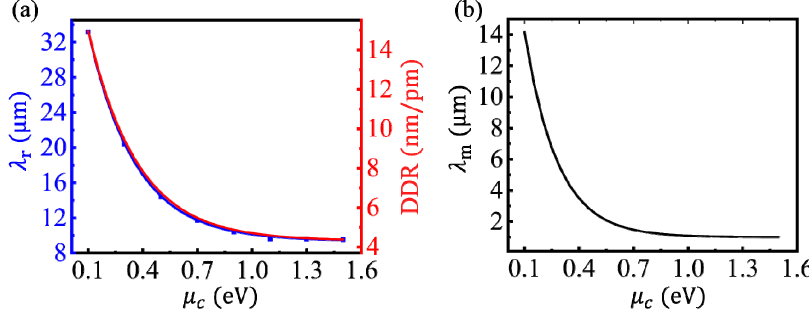
Figure 4. ( a ) The cross section of the CGS with a graphene ribbon array (GRA). ( b ) Dependences of the LSPR wavelength (blue line) and the DDR (red line), respectively, on the graphene ribbon (GR) width. ( c ) A frequency comb in the absorption spectrum is generated using a CGS with six GRs under μ c = 0.5 eV, n 3 = 1.5, and d = 1.0 nm.